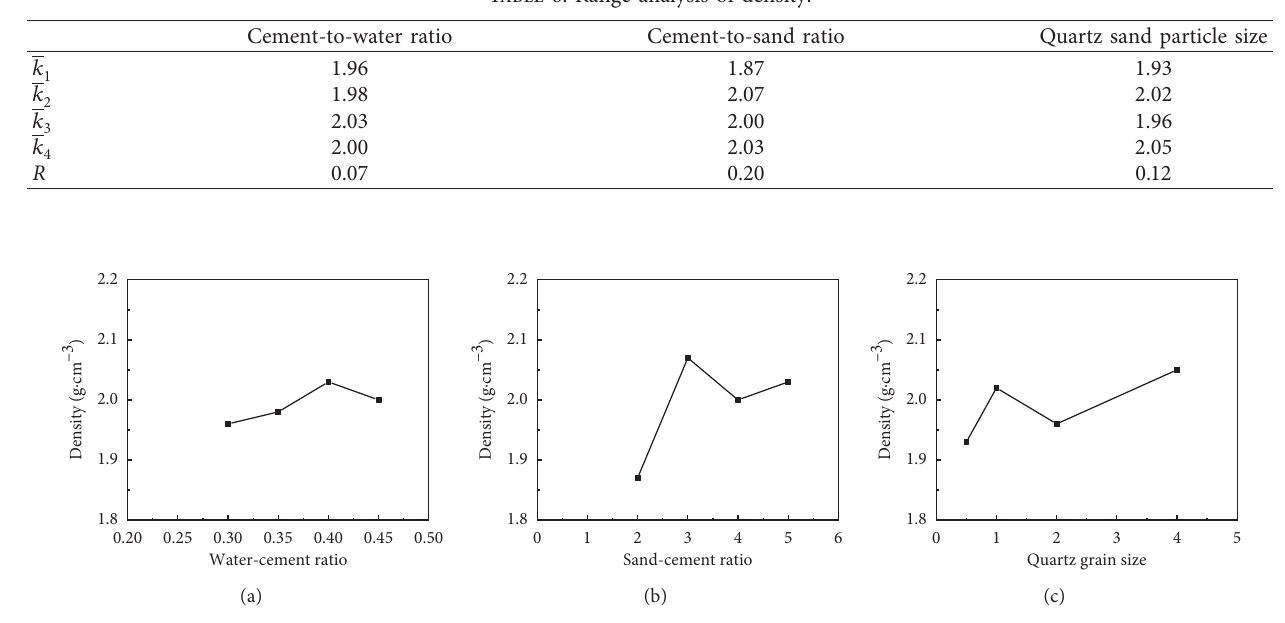
Figure 5: Sensitivity factor analysis of